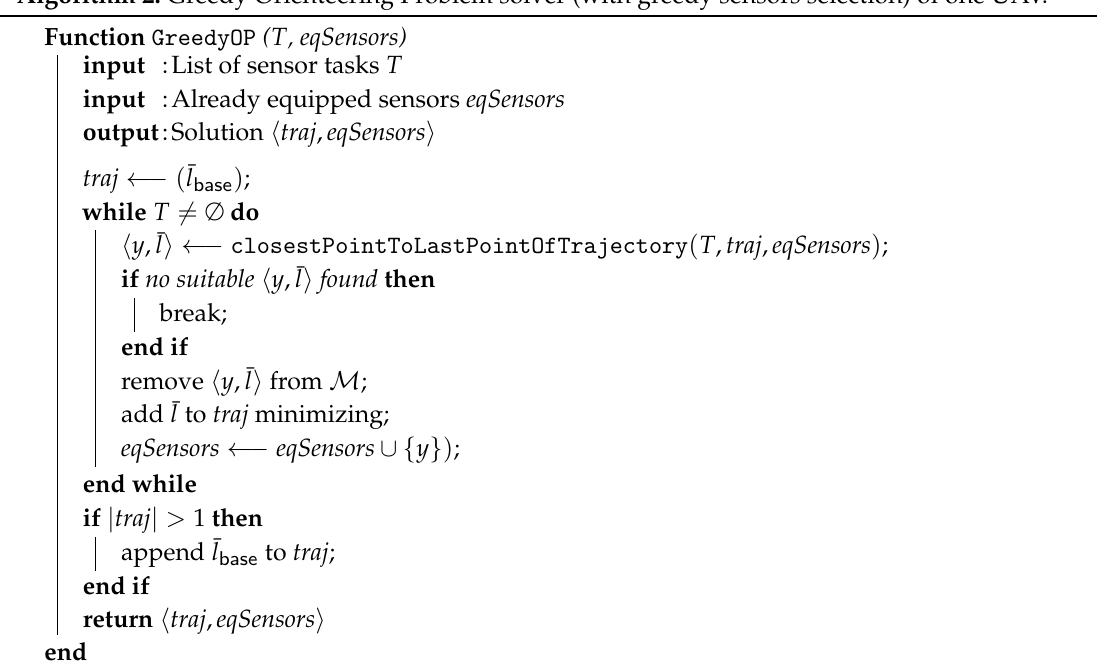
Algorithm 2: Greedy Orienteering Problem solver (with greedy sensors selection) of one UAV. Function GreedyOP (T,